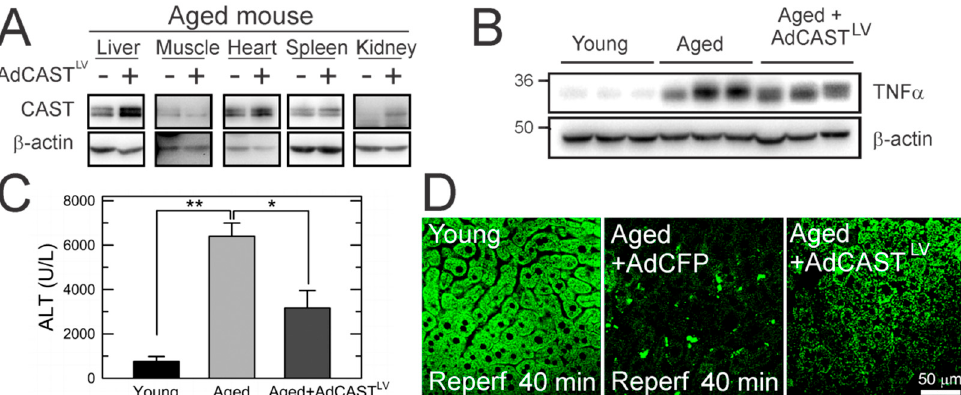
Figure 7. Cytoprotection of aged mouse livers by CAST overexpression after in vivo I/R. ( A ) Liver-specific delivery of adenoviral CAST. Change in ( B ) hepatic expression of tissue TNF α and ( C ) serum levels of ALT after 24 h of reperfusion in young and aged mouse livers with and without CAST overexpression ( n = 3). ( D ) Multiphoton images of young and aged livers after I/R in vivo. * p < 0.05 and ** p < 0.01.